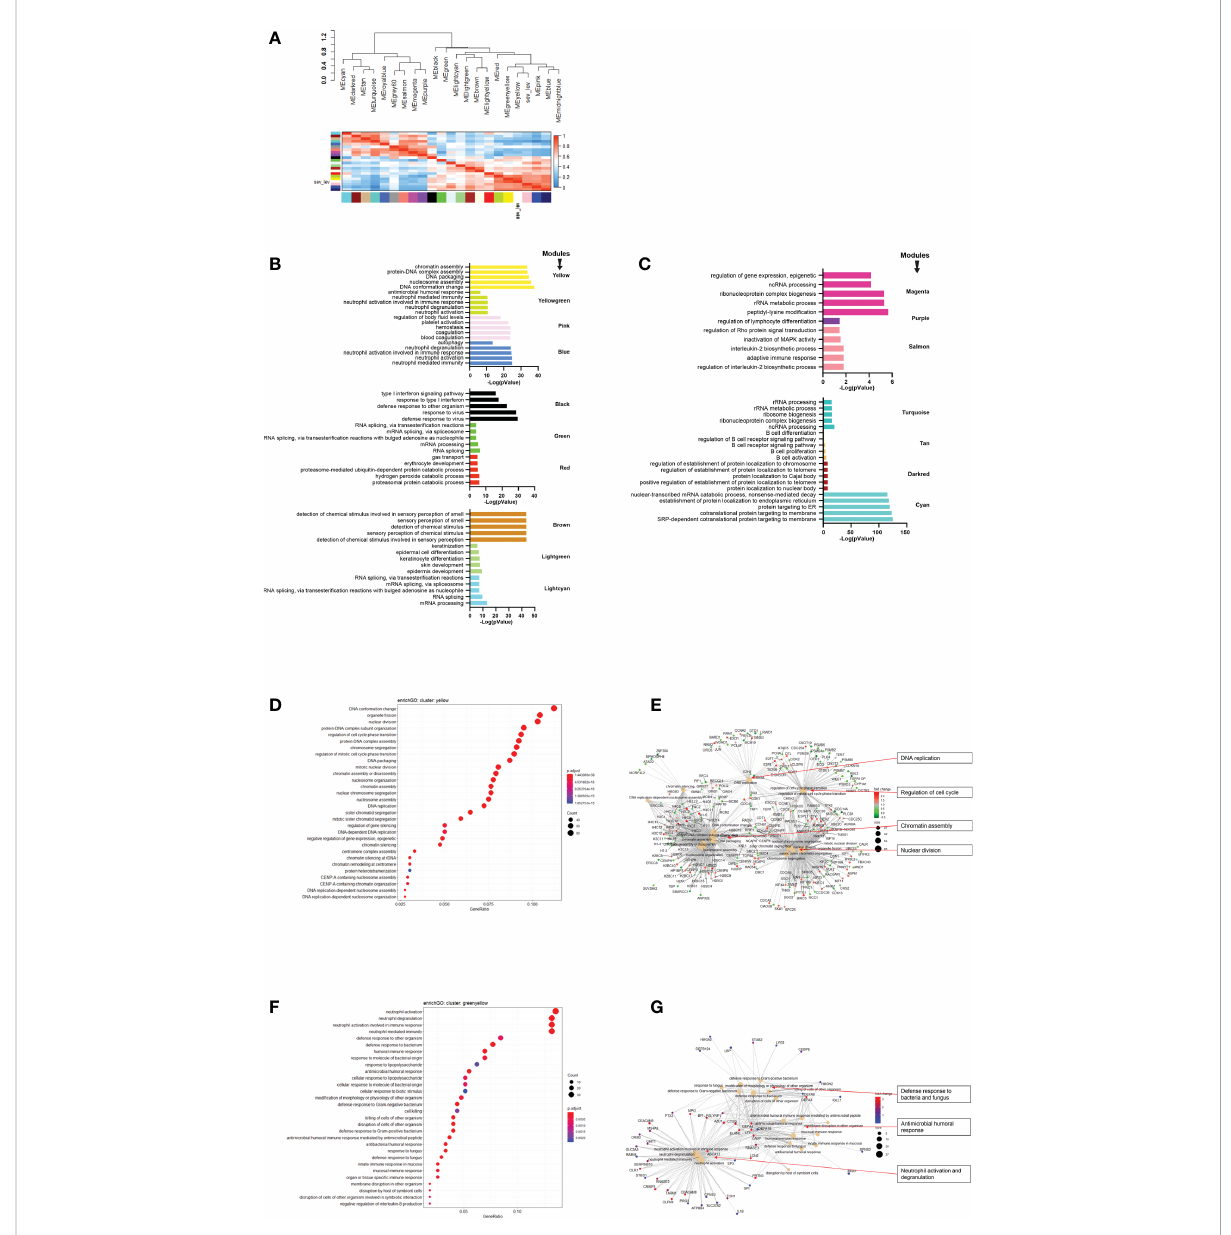
FIGURE 4 Modules from Weighed Gene Correlation Analysis (WGCNA). (A) Dendrogram showing clustering of modules identi fi ed by WGCNA. WHO severity levels are correlated with yellow and greenyellow modules. (B) & (C) Bar diagram showing the top 5 (by adjusted p-value) pathways associated with each of the 17 modules as identi fi ed by WGCNA. The signi fi cance level is indicated as -Log 10 (adjusted p-value). (D) Functional analysis using GO term enrichment for genes in yellow module showing the 30 most signi fi cant pathway annotations. (E) cnetplot illustrating relationship of genes from yellow module to pathways. (F) Functional analysis using GO term enrichment for genes in greenyellow module showing the 30 most signi fi cant pathway annotations. (G) cnetplot illustrating relationship of genes from greenyellow cluster to pathways. Nodes in cnetplots represent pathways signi fi cantly associated with the genes from the respective module. Genes from the module are connected to these nodes with color-coded log-fold changes from the contrast between severe cases versus healthy controls. Abbreviations: sev_lev stands for WHO severity